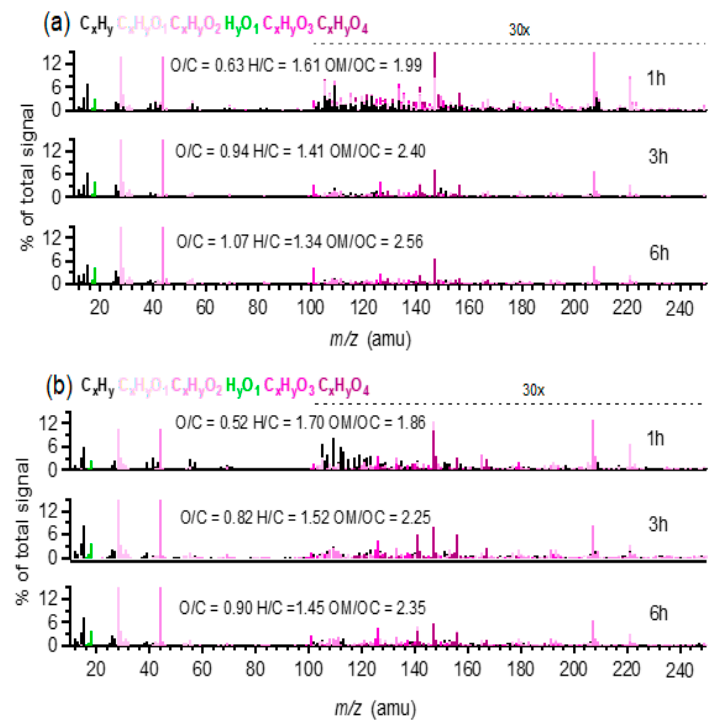
Figure 4. High resolution mass spectra of ( a ) MHQ + OH and ( b ) MHQ+3,4-DMB at different reaction times. The hydrogen-to-carbon (H/C) and O/C ratios and OS c values are also shown for each mass spectrum. The colored sticks represent the following six ion families: C x H y , C x H y O 1 , C x H y O 2 , H y O 1 , C x H y O 3 , and C x H y O 4 . The ion signals at m/z > 100 are amplified 30 × for clarity.